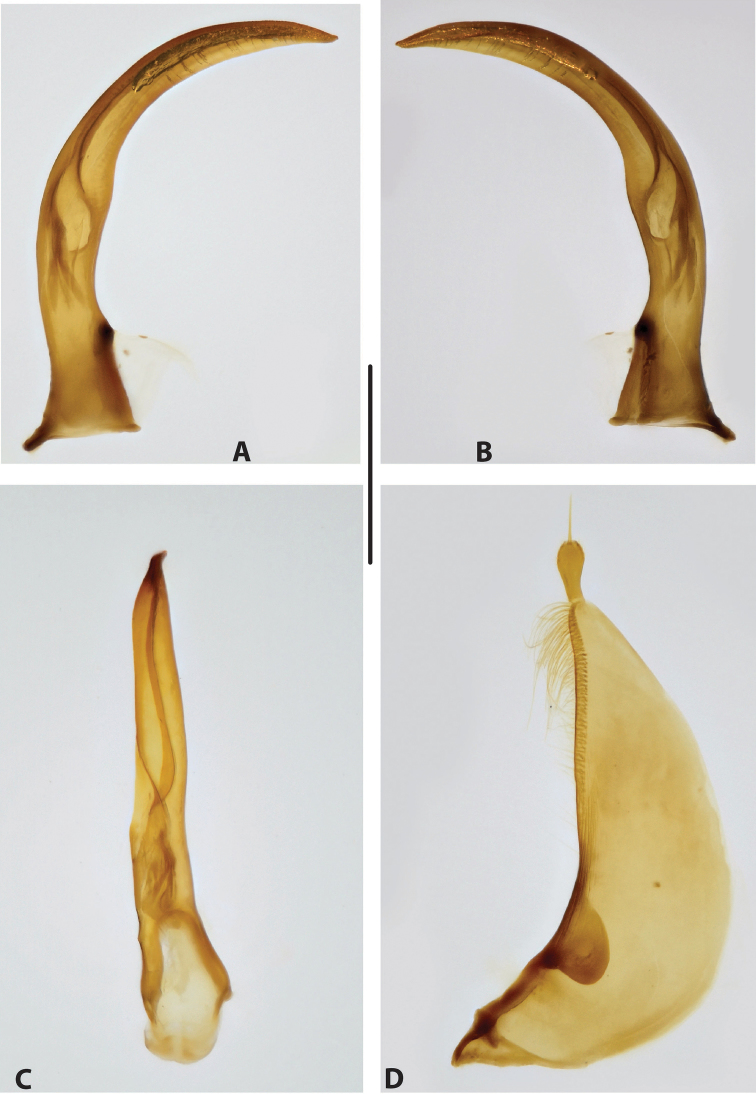
Copelatus
marginatusA median lobe in lateral view, right side B median lobe in lateral view, left side C median lobe in ventral view D left paramere in external view. Scale bar: 0.5 mm.